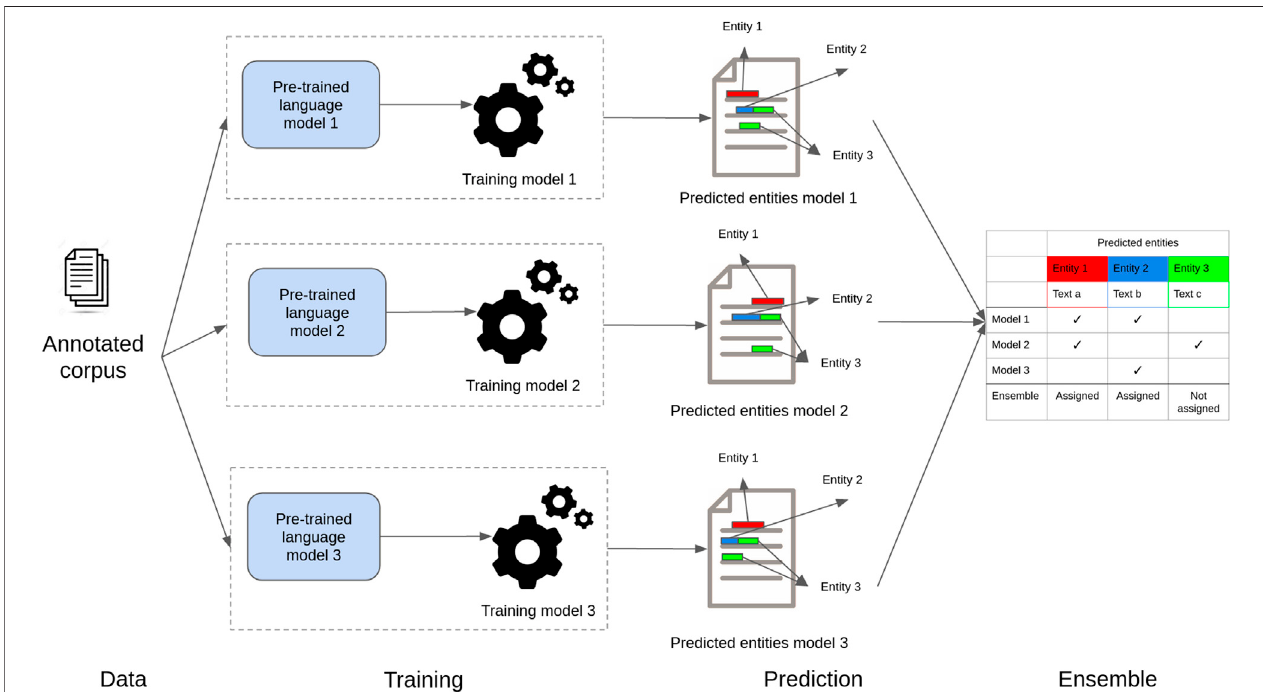
FIGURE 4 | Schematic presentation of the ensemble model. Individual models are fi ne-tuned with speci fi c task data. Then, they are used to classify tokens independently. The predictions are then combined using majority